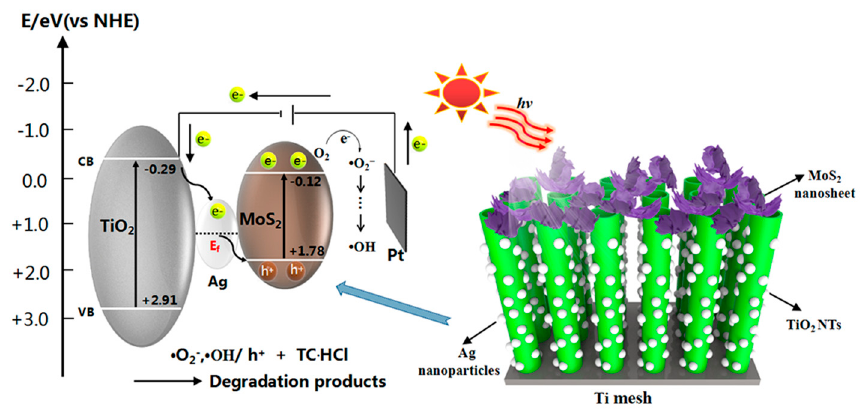
Scheme 1. Schematic illustration of proposed mechanism of the photogenerated electrons and holes